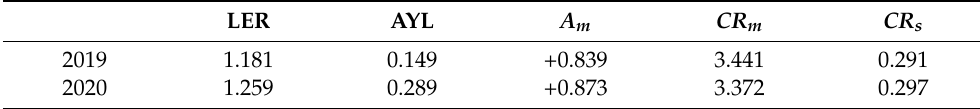
Table 5. Yield and competition